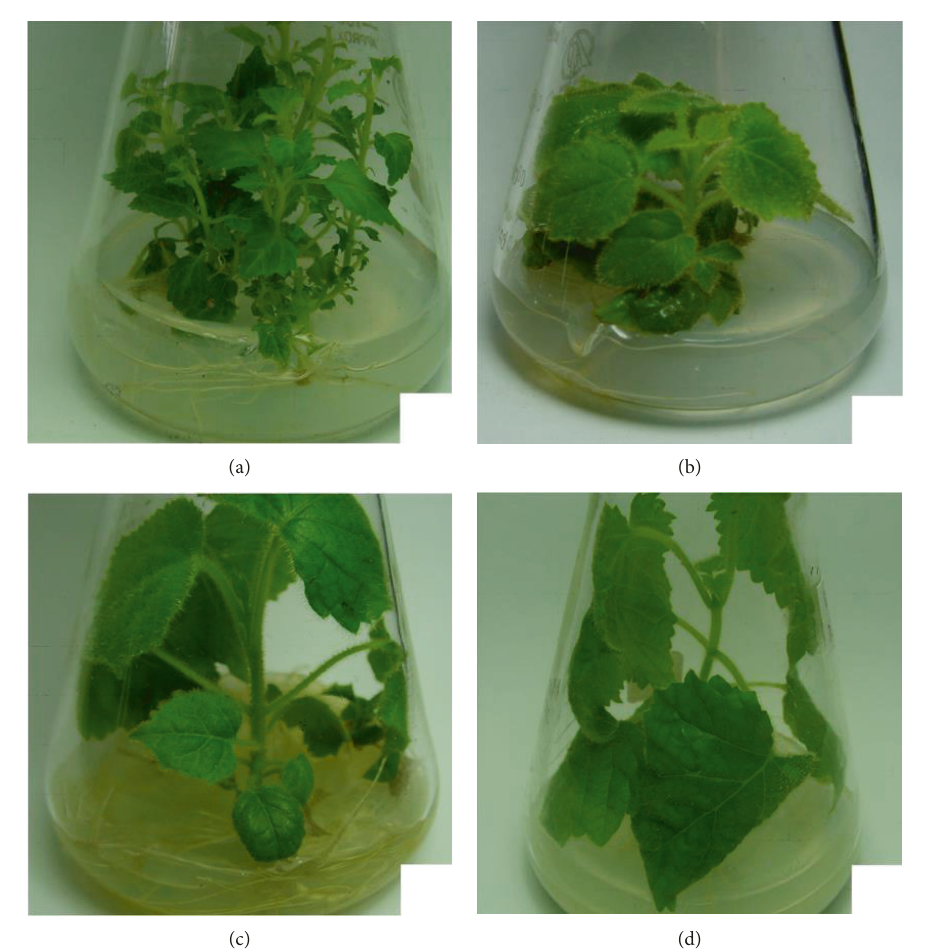
Figure 1: Morphology of P. fortunei seedlings treated with dimethyl sulfate (DMS). (a) Morphology of PFI. (b) Morphology of 15 mg · L − 1 DMS-treated PFI. (c) Morphology of 75mg · L − 1 DMS-treated PFI. (d) Morphology of